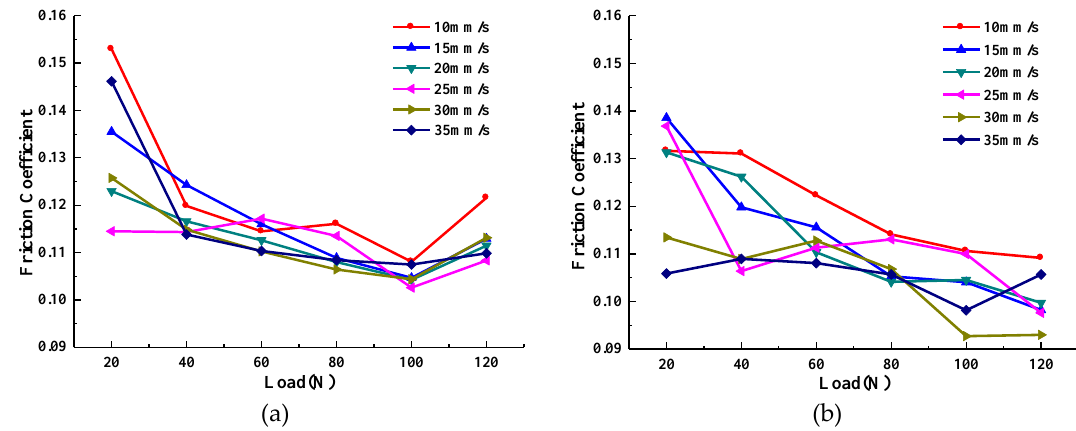
Figure 4. Average coe ffi cient of friction (COF) curves of sample oil varies with loads: ( a ) flake micron WS 2 ; ( b ) spherical nano-WS 2